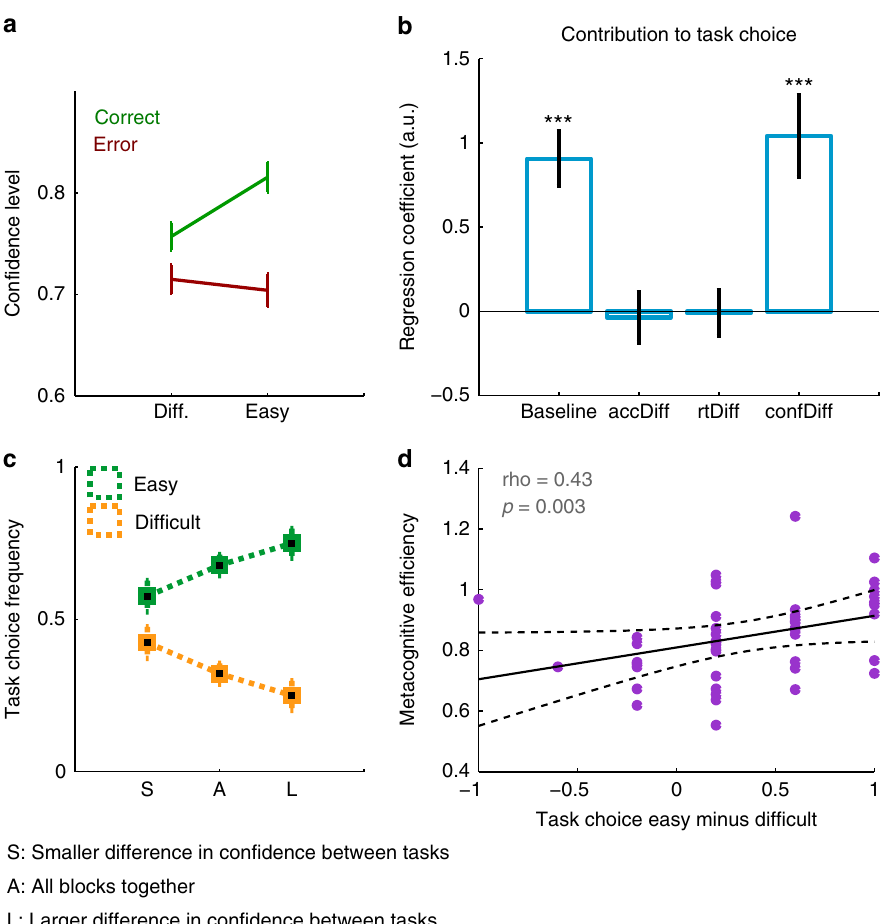
Fig. 5 Relating local con fi dence to global SPEs in Experiment 3 ( N = 46). a Subjects rated their con fi dence higher when they were correct than incorrect, and this difference was greater when the task was easier, indicating that local con fi dence ratings were sensitive to changes in objective performance. Error bars indicate S.E.M. across subjects. b Logistic regression indicating that the difference in con fi dence level between tasks (confDiff) explained subjects ’ task choices over and above a difference in accuracy (accDiff) and RTs (rtDiff). Error bars indicate S.E. over regression coef fi cients. *** p < 0.0001 indicates statistical signi fi cance of regression coef fi cient. c Fluctuations in local con fi dence are predictive of task choices made at the end of blocks. When the difference in mean trial-by-trial con fi dence between both tasks on the block was larger ( “ L ” ) (respectively smaller, “ S ” ), the difference in task choice was larger (resp. smaller). Error bars indicate S.E.M. across subjects. d Between-subjects scatterplot revealing that subjects with higher metacognitive ef fi ciency were better at selecting the easiest task in end-of-block task choices. Purple dots are subjects ’ data, dotted lines are 95% CI. Note that task choice data are clustered in discrete levels due to a limited number of blocks per subject. See also Supplementary Fig. 3 and